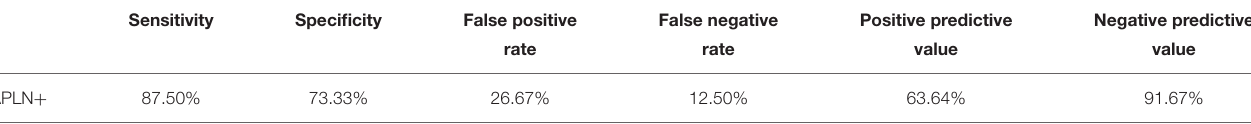
TABLE 7 | The predictive value of PSLNR for the status of APLN. Sensitivity Specificity False